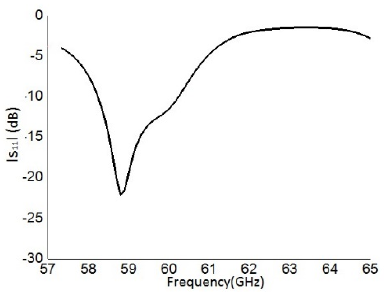
Figure 11. Simulated S-parameters curves versus frequency of the proposed mmWave 5G antenna.